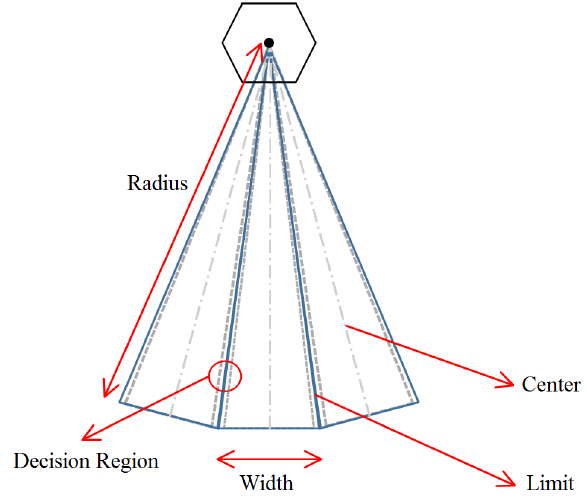
Figure 8. Regions and elements of interest for VOR misalignment analysis.